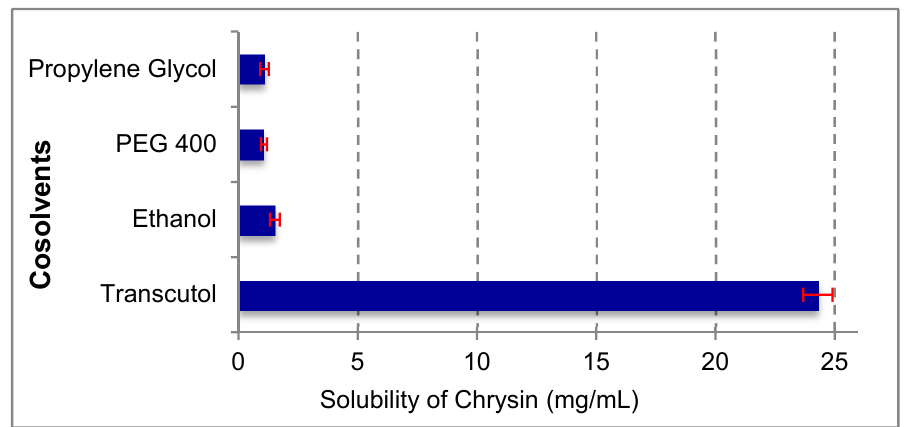
Figure 1. Solubility of chrysin in various oils, surfactants, and co-solvents ( n = 3 ± SD).